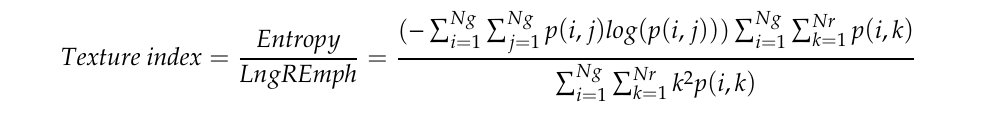
more intense the feature is at this point.